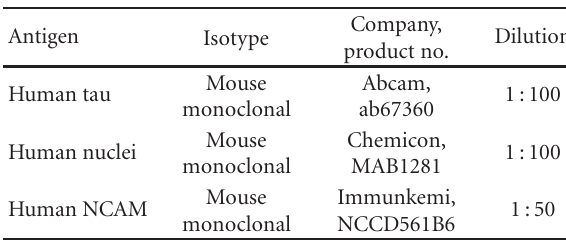
Table 1: Antibodies and dilutions used.